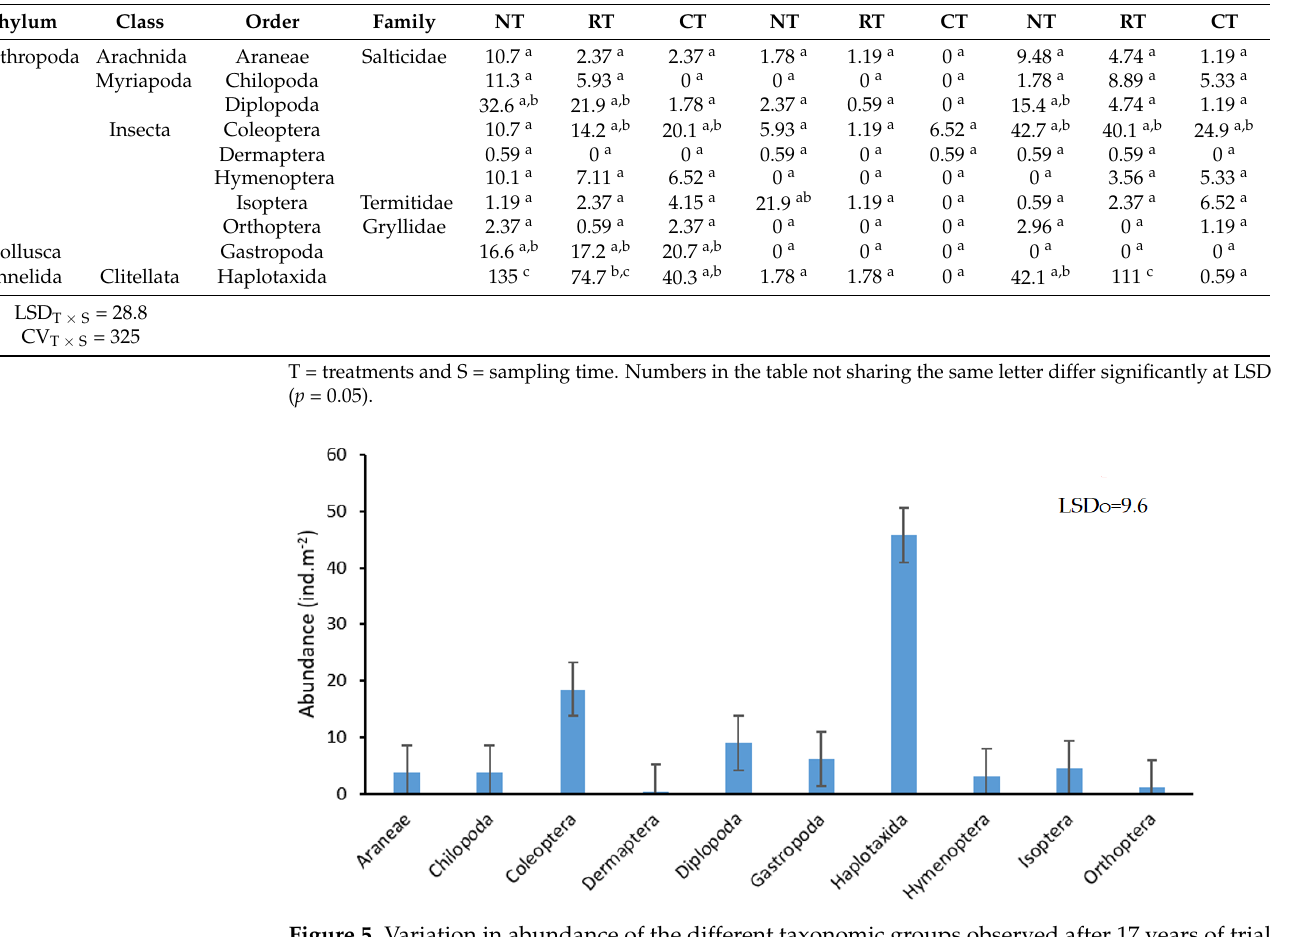
Figure 5. Variation in abundance of the different taxonomic groups observed after 17 years of trial establishment. O = orders.